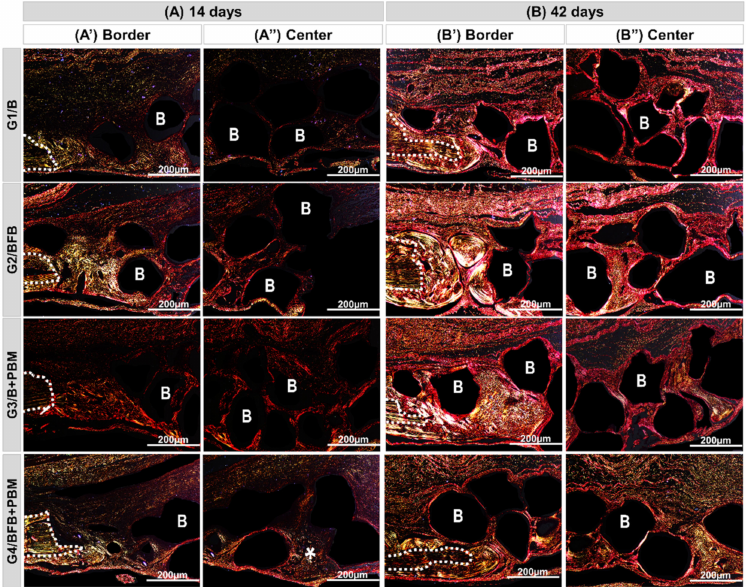
Figure 9. Histological sections of the edge (A’,A”) and center (B’,B”) of the bone defect of rat calvaria stained by Picrosirius-red under polarized light at 14 and 42 days (( A , B ), respectively). Biomate- rial (G1/B); biocomplex consisting of biomaterial plus heterologous fibrin biopolymer (G2/BFB); biomaterial and PBM (G3/B + PBM); and biocomplex consisting of biomaterial plus heterologous fibrin biopolymer and photobiomodulation with low-level laser therapy (G4/BFB + PBM). RGB green-yellow-red colors. Mature bone, type I collagen fibers: yellowish-green color; immature bone, type III collagen fibers: reddish color. Dashed line = edge of remaining bone; B = synthetic biomate- rial particles (dark background); asterisk = collagen fibers in advanced maturation phase. Original magnification × 10, scale bar 200 µ m.